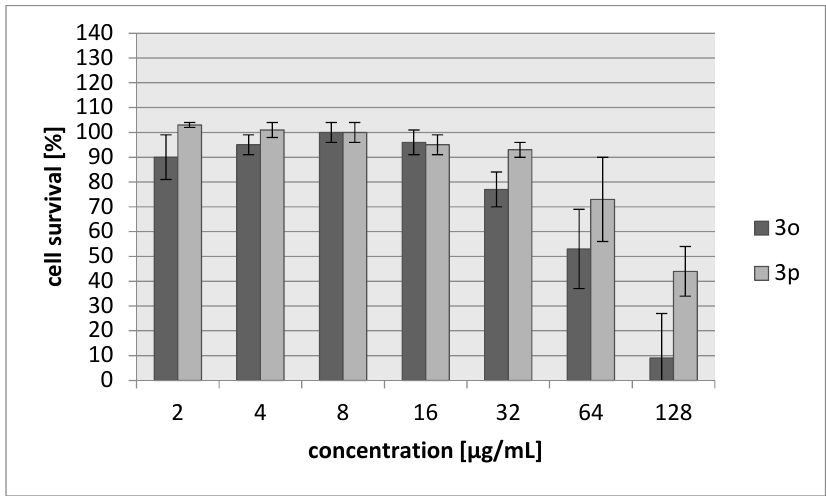
Figure 6. Concentration-dependent cytotoxic activity of 3o and 3p for HeLa cell line.